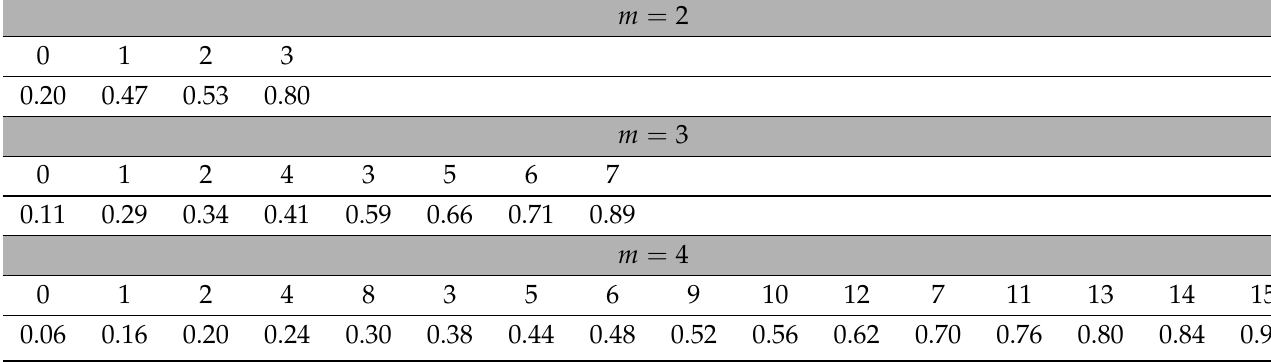
Table 3. Average reliability of the synthetic